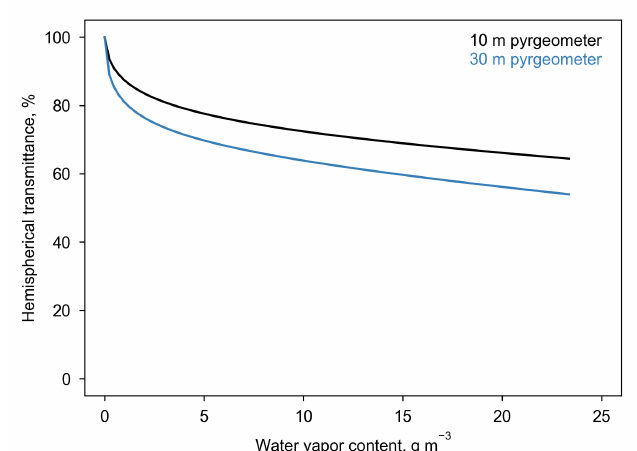
Figure 11. Hemispherical at-sensor atmospheric transmittance as a function of water vapor content for two pyrgeometer heights (10 m and 30 m) over a flat surface. Results calculated as the fraction of surface emission reaching the sensor height using MODTRAN 4.1 [15] with T surf = T air = 300 K, water vapor as the sole atmospheric absorber, and density and pressure from the Standard Atmosphere profile [25].